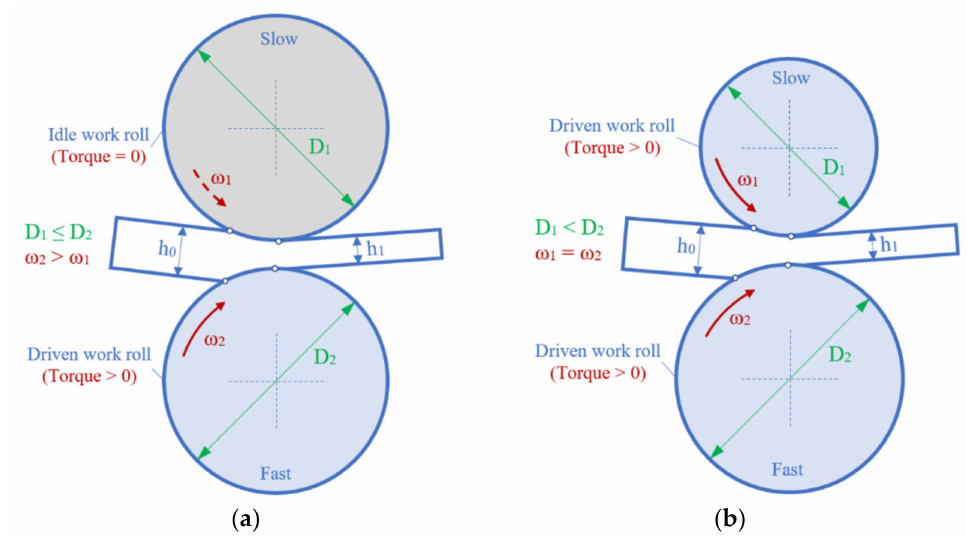
Figure 6. Schematic illustration of asymmetric rolling processes due to different circumferential speeds of the work rolls: ( a ) Rolling with idle work roll (“Single roll driven rolling”); ( b ) rolling with different diameters of top and bottom work rolls.